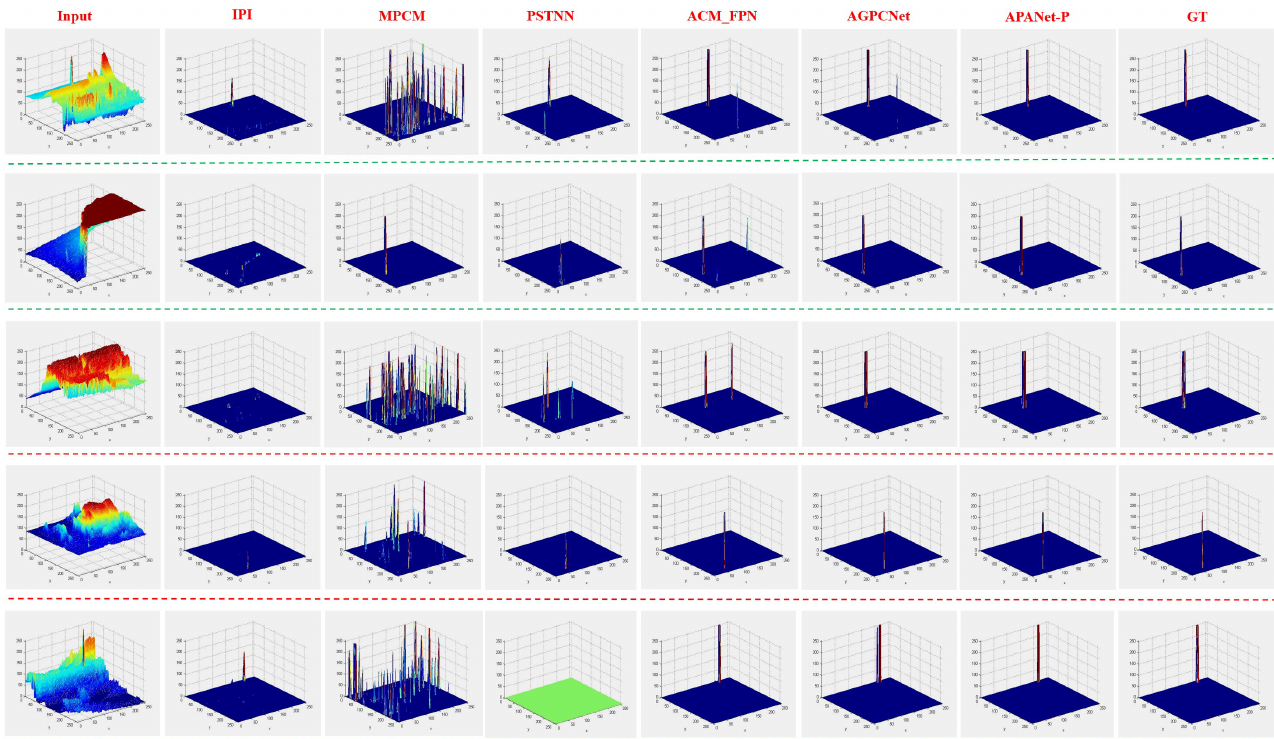
Figure 9. 3D visualization results of different small infrared target detection